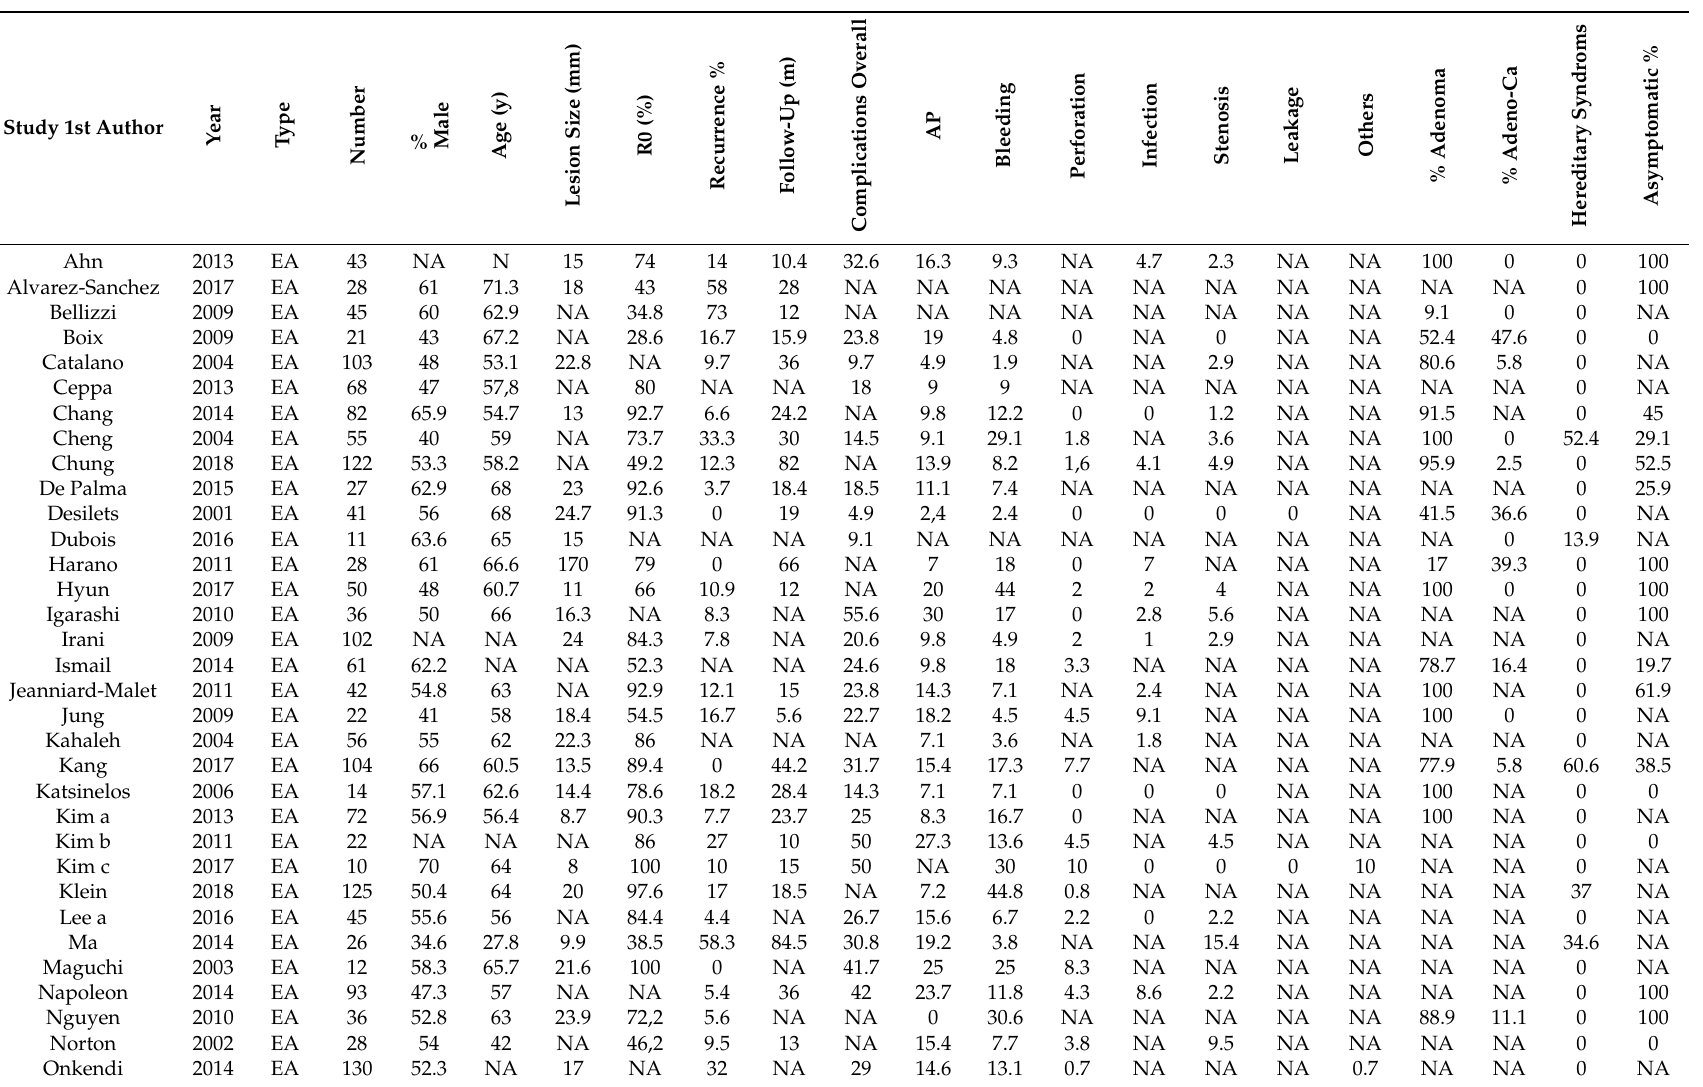
Table 3. Outcomes of the included